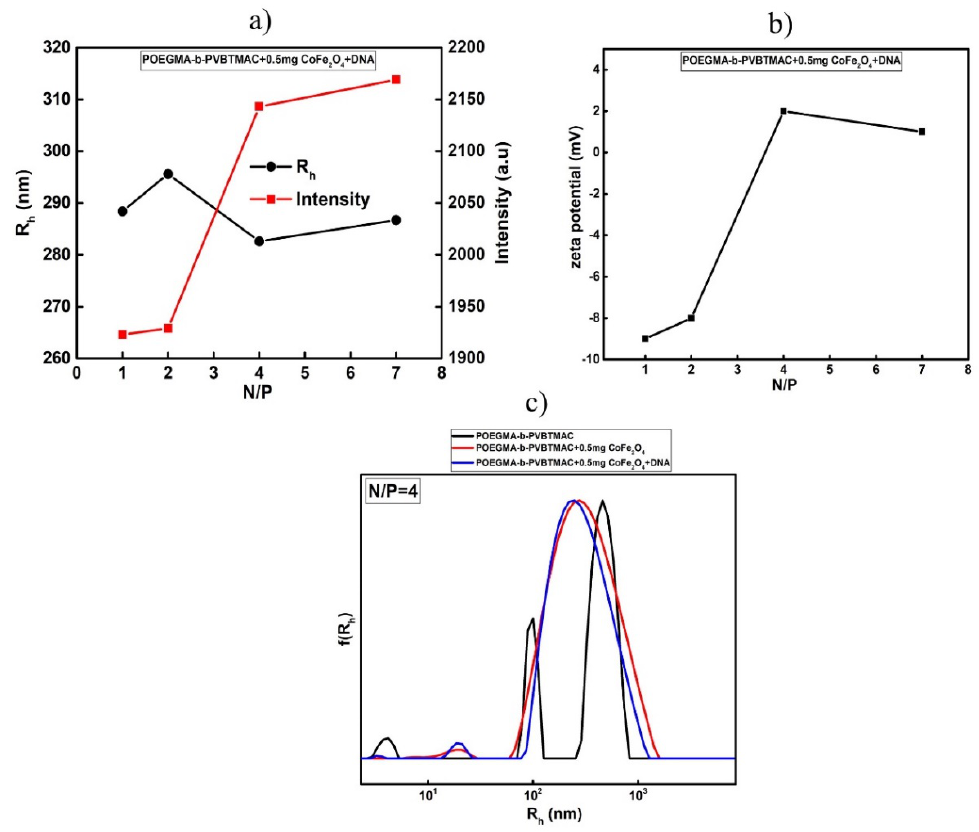
Figure 6. ( a ) R h , scattered intensity and ( b ) ζ potential as a function of N/P ratio for the formed magnetopolyplexes at N / P = 7, 4, 2 and 1, ( c ) comparison of the size distributions from CONTIN analysis for POEGMA- b -PVBTMAC copolymer, MNPs–hybrid complexes and magnetopolyplexes at N / P = 4 and at 0.01 M NaCl.